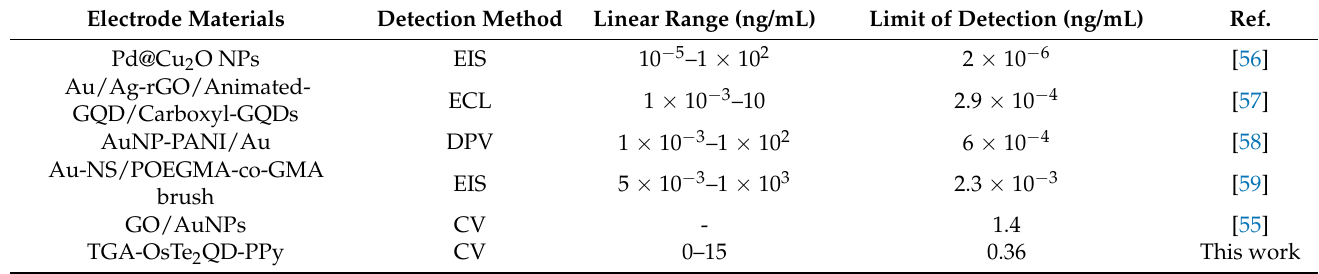
Table 2. Comparison of the proposed method with already reported immunosensor for